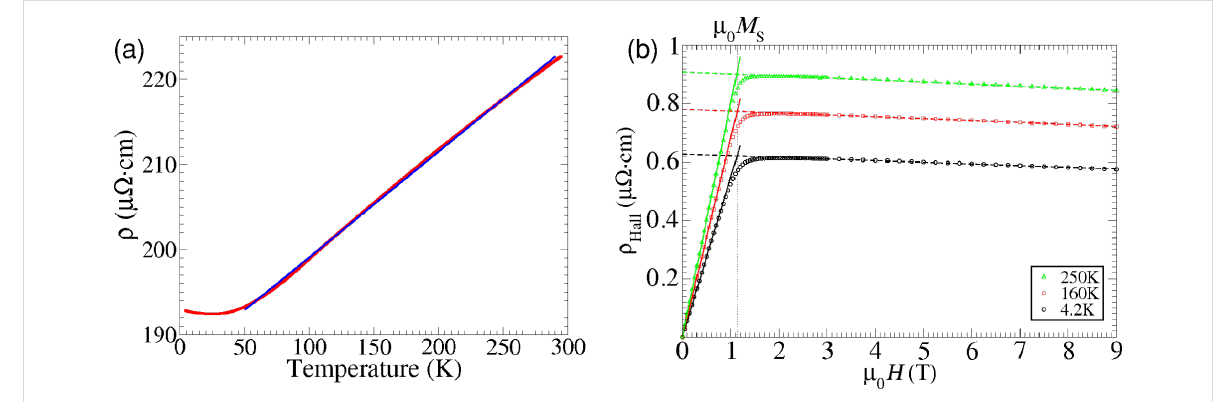
Figure 4: (a) Temperature dependence of resistivity of Co deposit grown on the plasma-activated SiO 2 surfaces. The lateral shape of the deposit for resistivity and Hall effect measurements was defined by a lift-off procedure of a photolithographically defined resist pattern on which the plasma- activated growth had been performed. The deposit height was determined as 55 nm by atomic force microscopy. Blue line: linear fit between 50 and 290 K. (b) Hall resistivity as function of magnetic field, measured at different temperatures as indicated. The saturation magnetization is denoted as μ 0 M S .